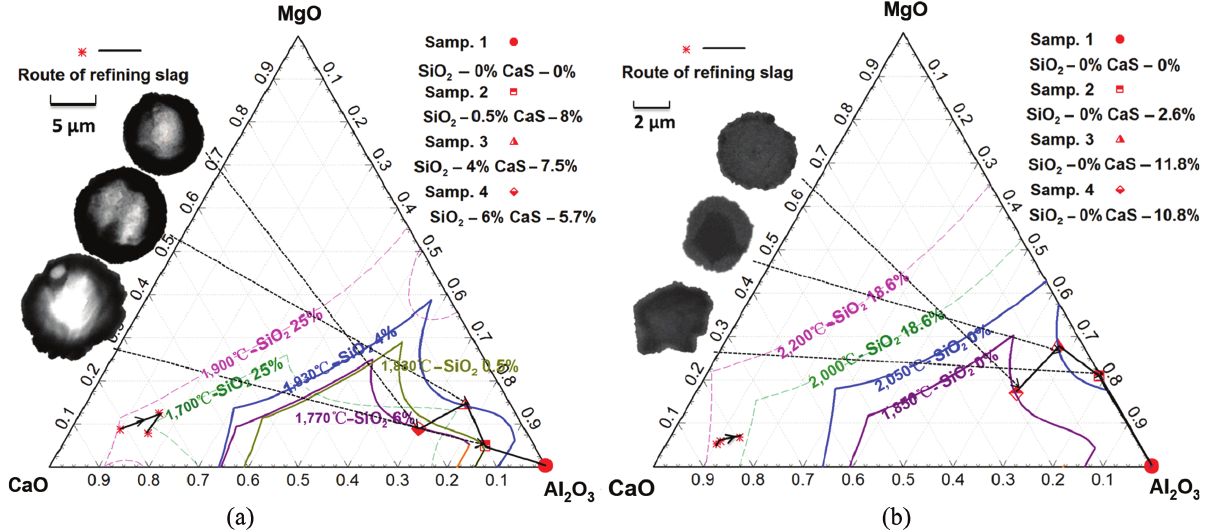
Figure 4: Phase diagram of MgO – CaO – Al 2 O 3 – SiO 2 slag with experimental compositions: (a) conventional slag and (b) experimental